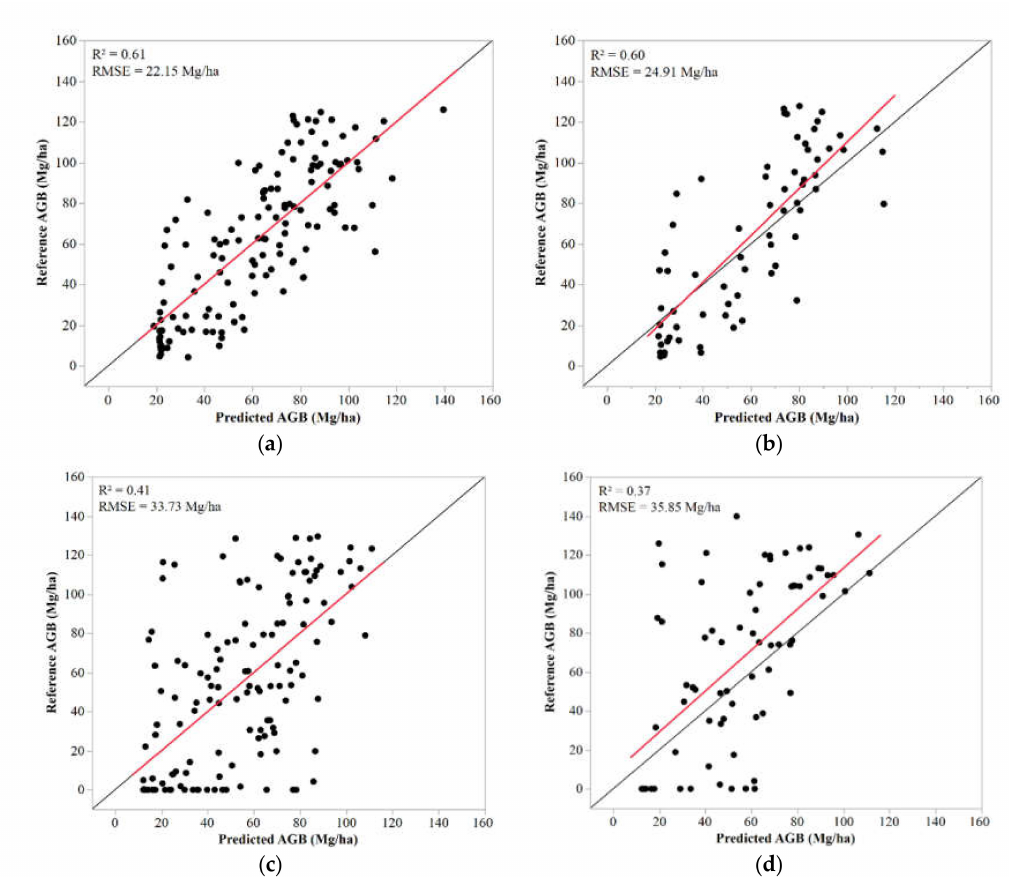
Figure 4. ( a ) Reference AGB versus ICESat-2-predicted AGB (Mg / ha) with training data, for the strong beam; ( b ) reference AGB versus ICESat-2-predicted AGB (Mg / ha) with test data, for the strong beam; ( c ) reference AGB versus ICESat-2-predicted AGB (Mg / ha) with training data, for the weak beam; ( d ) reference AGB versus ICESat-2-predicted AGB (Mg / ha) with test data, for the weak beam. The solid black line in each graph is the 1:1